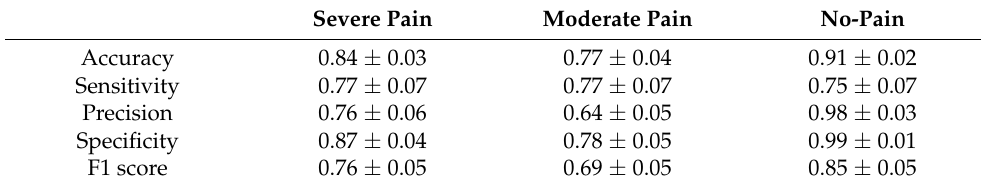
Table 3. Multiclass evaluation results of 10-fold cross-validation (AdaBoost).